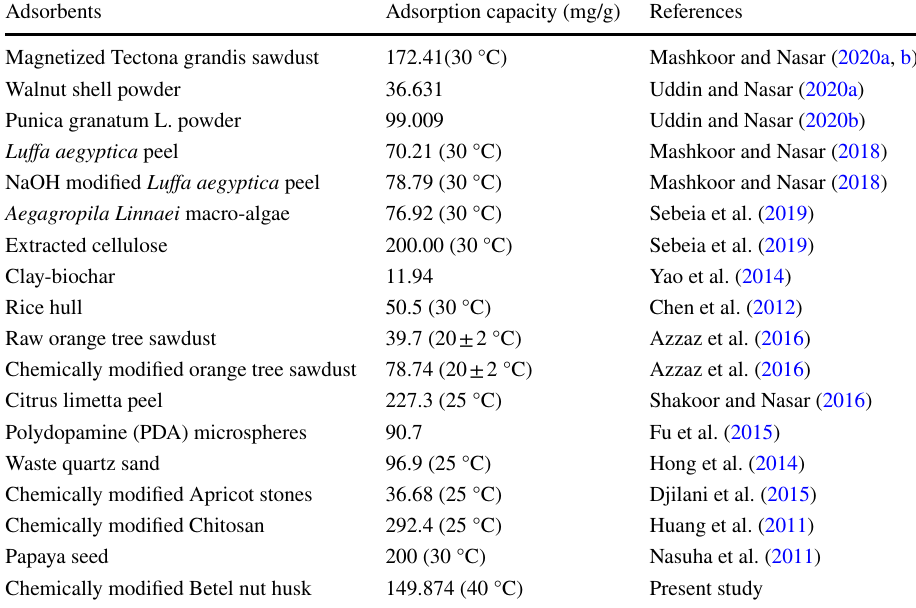
Table 3 Comparison of adsorption capacity of BNH-CM with other adsorbent materials